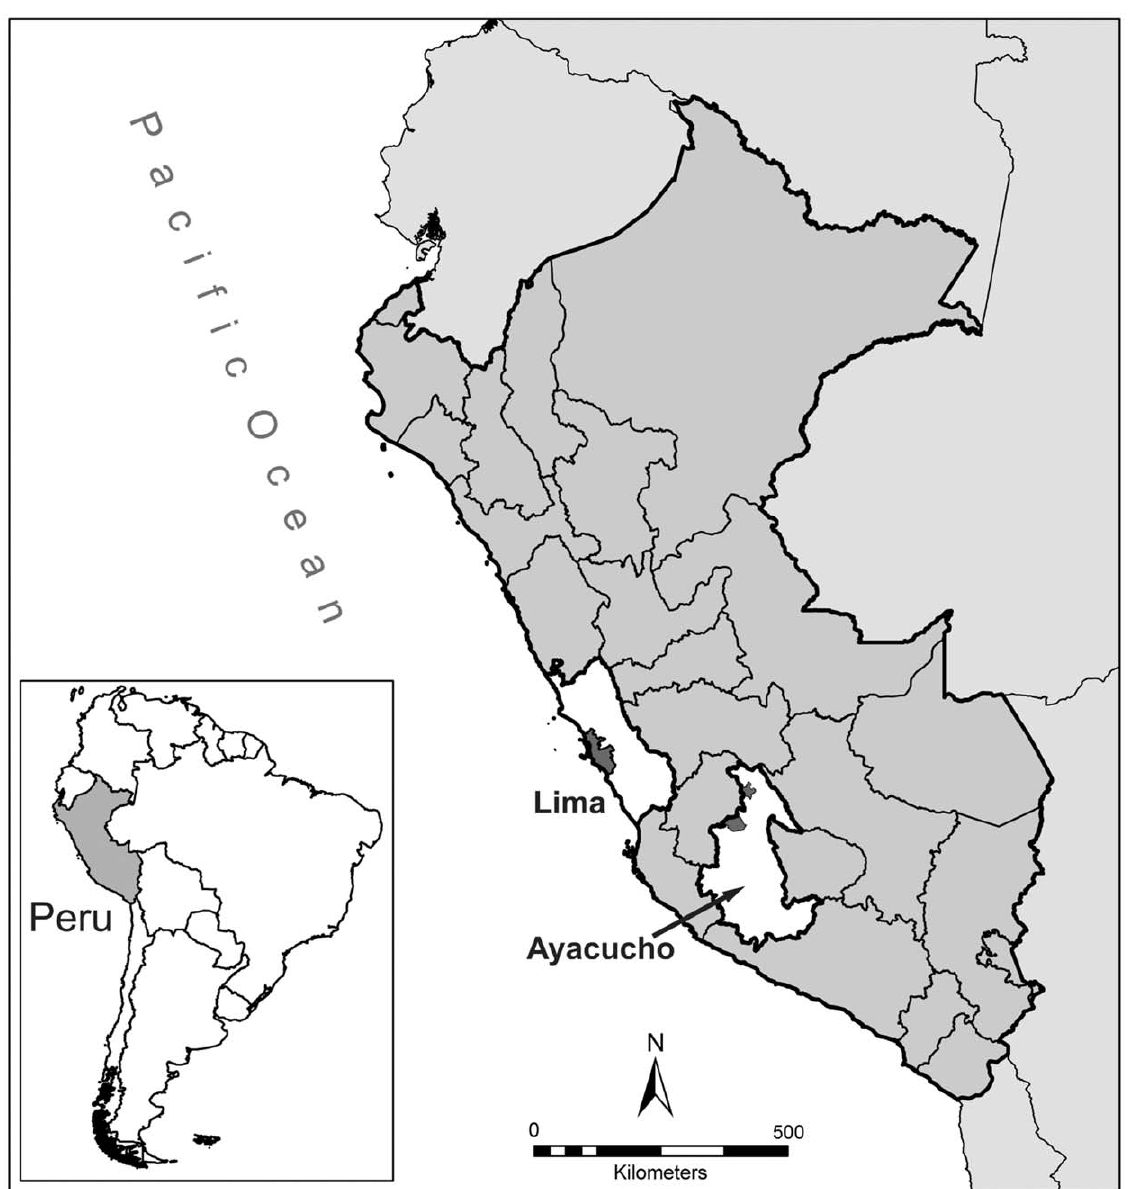
Figure 1. Map of Peru showing location of study sites. Lima and Ayacucho Regions illustrated in white. Dark grey areas illustrate Lima metropolitan area and Districts of Vinchos (south) and Santillana (north) in